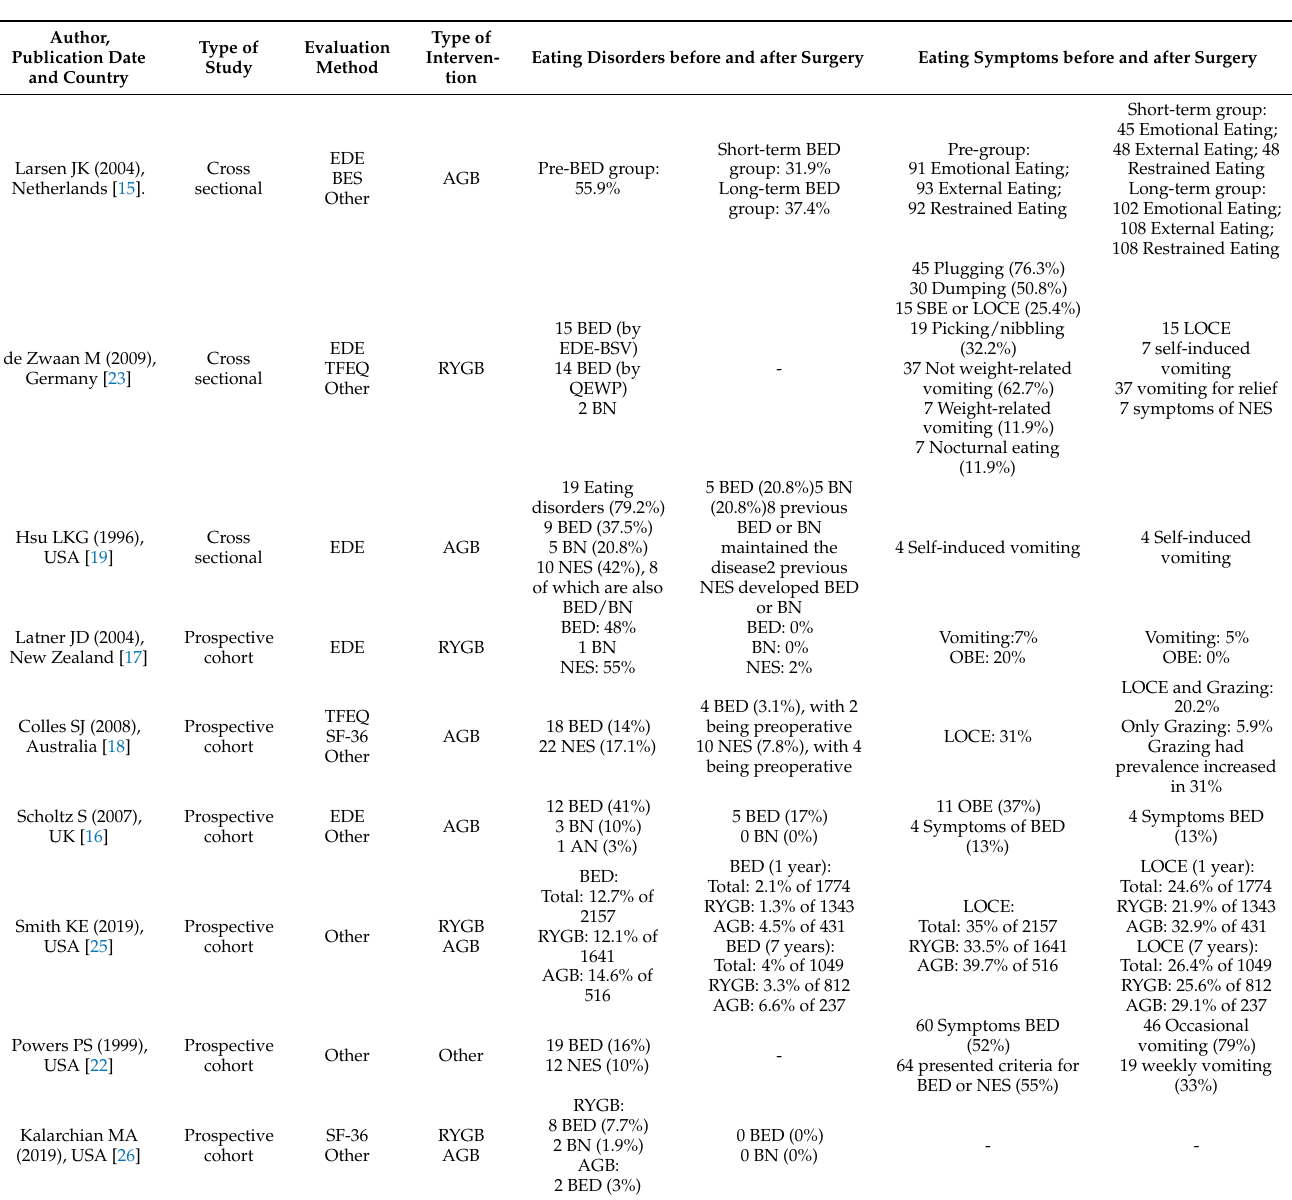
Table 4. Observational studies main